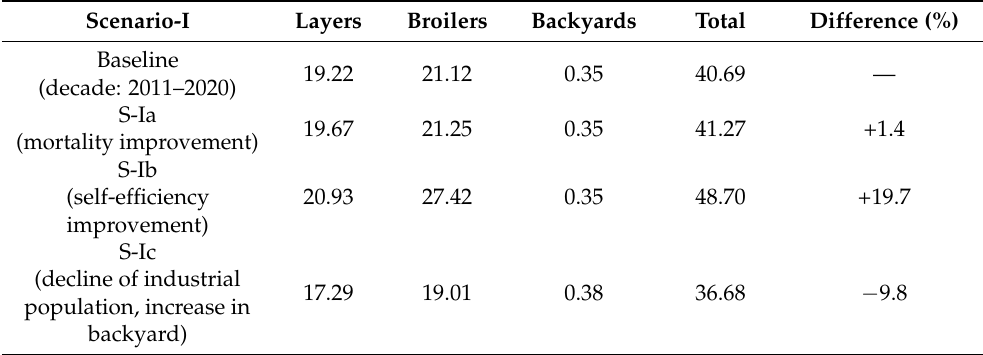
Table 2. Results of mitigation Scenario-I (changes in population/herd numbers) in the total GHG emissions (×10 9 kg CO 2 -eq/year) at the national level.